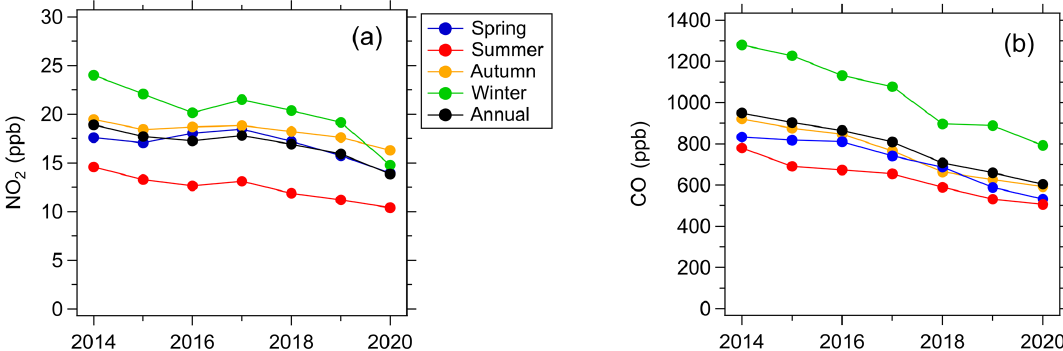
Figure 7. Variations in seasonal and annual average concentrations of NO 2 and CO measured during 2014–2020 in China.